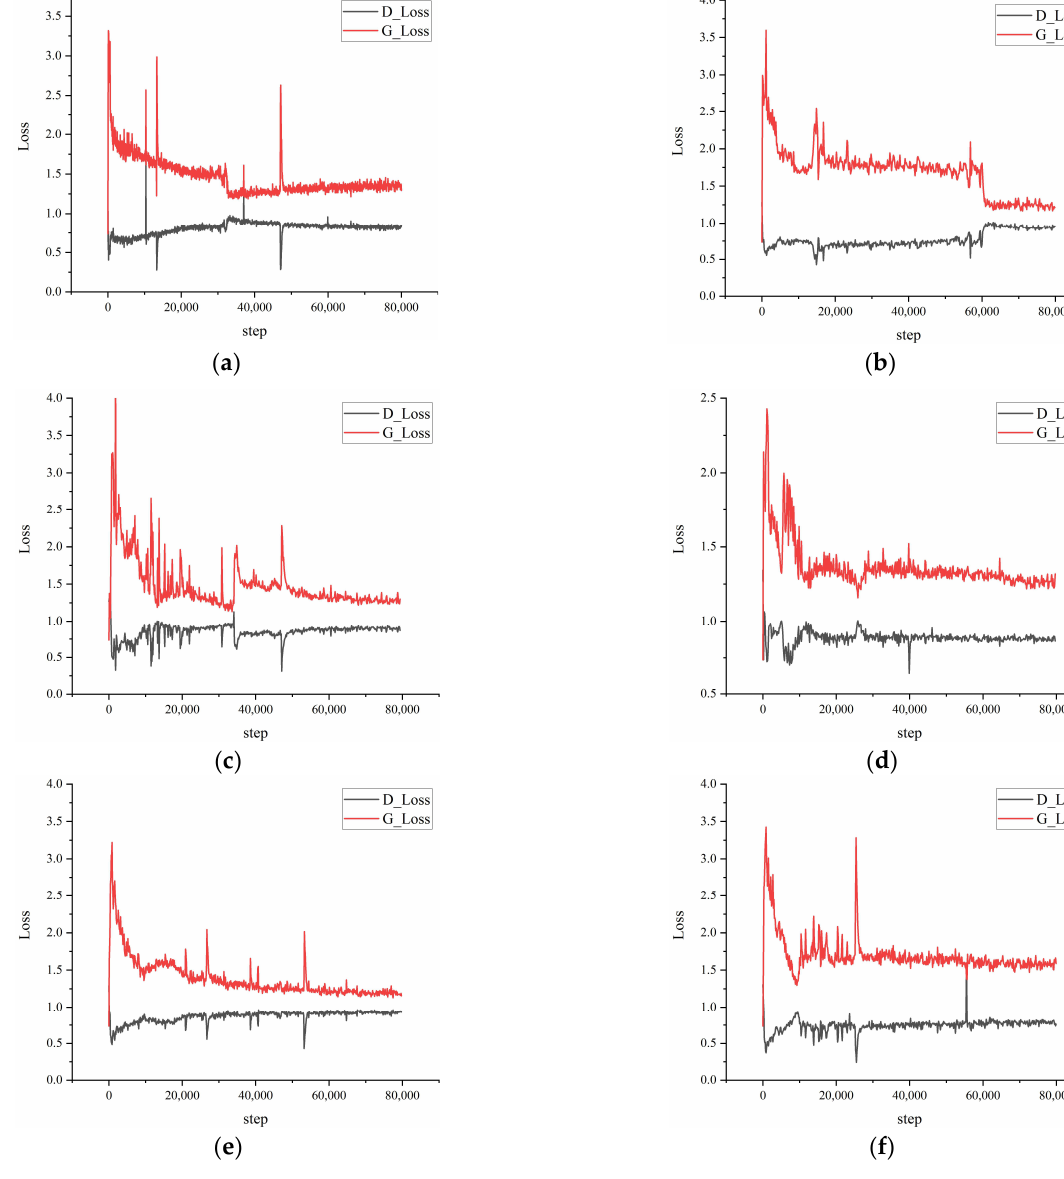
Figure 9. Loss curves of StyleGAN-DSAD. ( a ) all; ( b ) coal; ( c ) gangue; ( d ) bag; ( e ) iron; ( f ) wood.